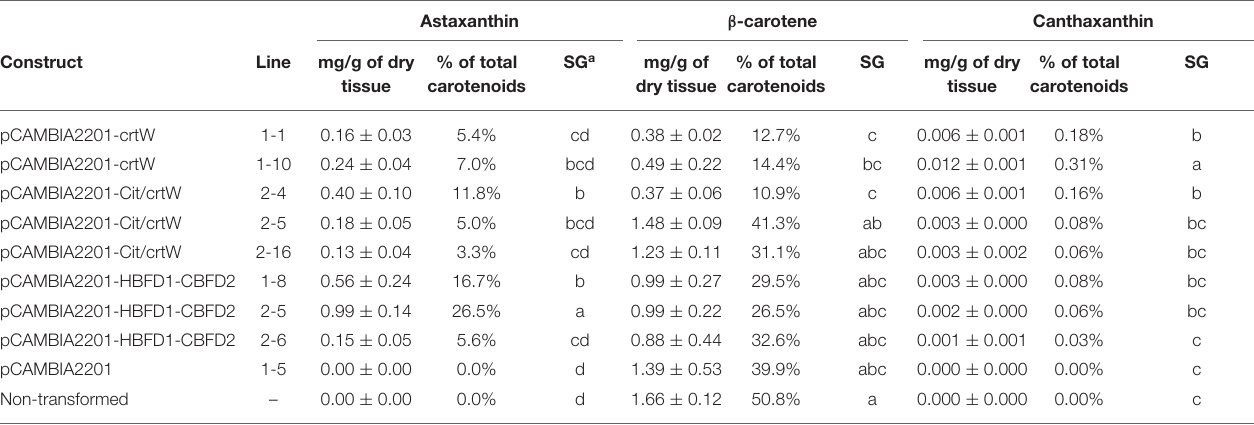
TABLE 2 | Quantification of the carotenoids astaxanthin, β -carotene, and canthaxanthin in T1 N. benthamiana leaves using high performance liquid chromatography coupled with mass spectrometry. Astaxanthin β